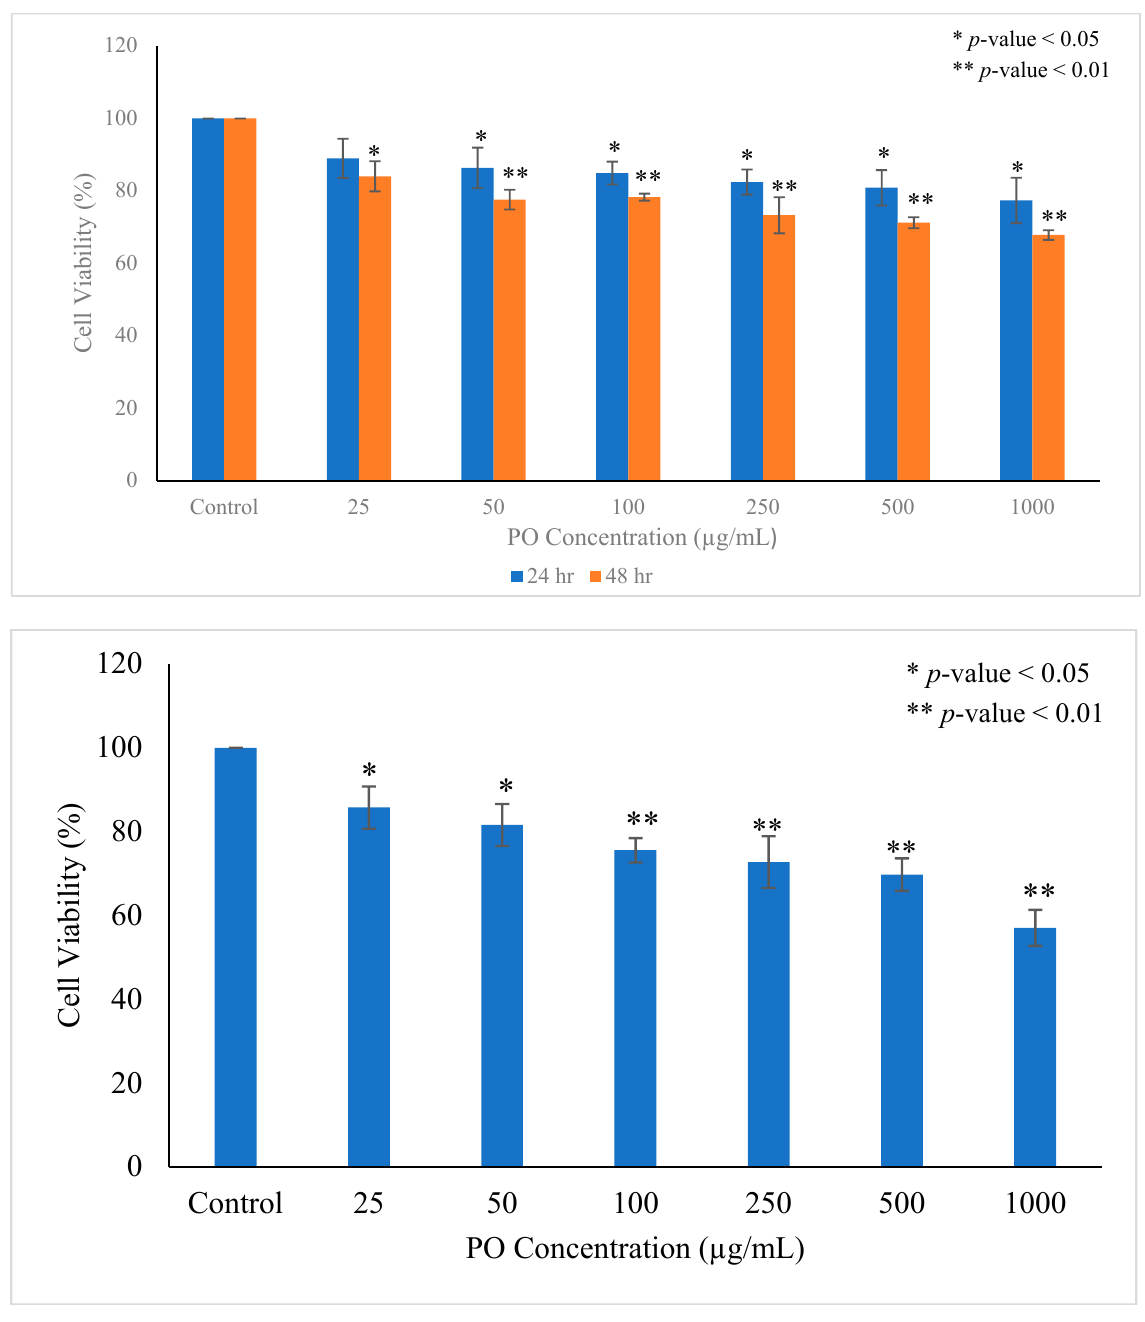
Figure 6. Statistical analysis of cellular viability using PrestoBlue and SRB assays after treating the cells with various concentration of Pleurotus ostreatus extract ranging from 25 to 1000 µ g/mL at different time points (24 and 48 h). The results were analyzed using two-way ANOVA; data are expressed as mean ± standard deviation (SD), n = 3. The significance is represented as * p < 0.05, ** p < 0.01.